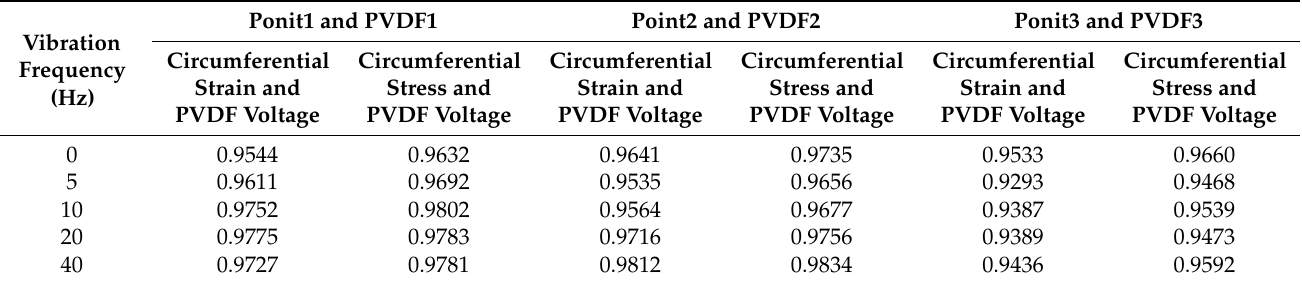
Table 8. Correlation coefficient.